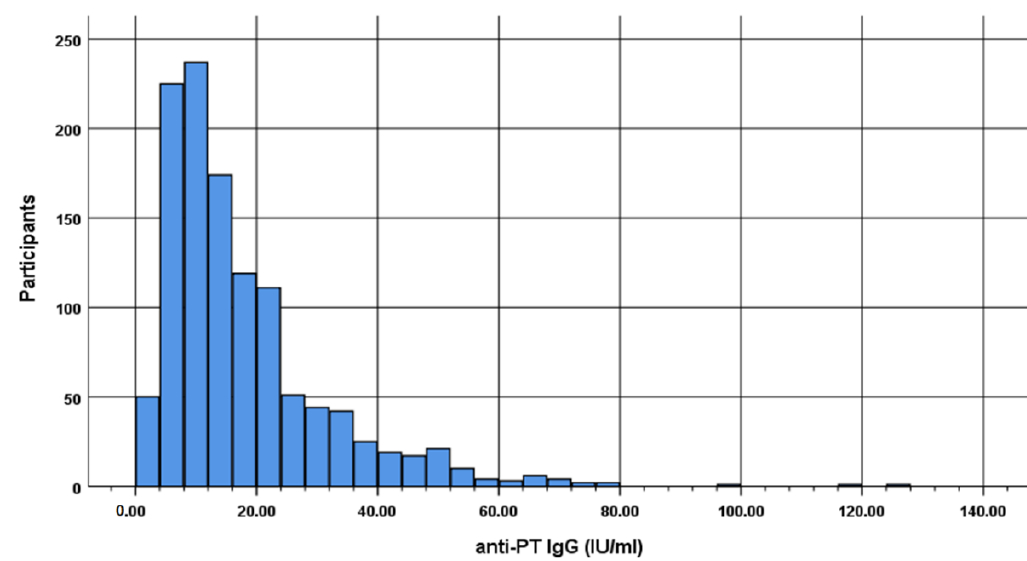
Figure 1. Histogram of anti-PT IgG distribution IU/mL (in groups by 4 IU/mL). According to the laboratory method used in our study, we report 44 participants (3.7% of the study population) with positive anti-PT IgG > 50 IU/mL. Furthermore, in analysis of pertussis prevalence by sex, we observed statistically significant difference among participants with males to present a twofold percentage 5% than females 2.6% ( p -value 0.026). The region of Peloponnese recorded the highest proportion, with 16.4% of antibodies levels more than >50 IU/mL, followed by the region of Thessaly, with 7.4%, and the regions with the lowest proportion were the North Aegean, West Macedonia, and